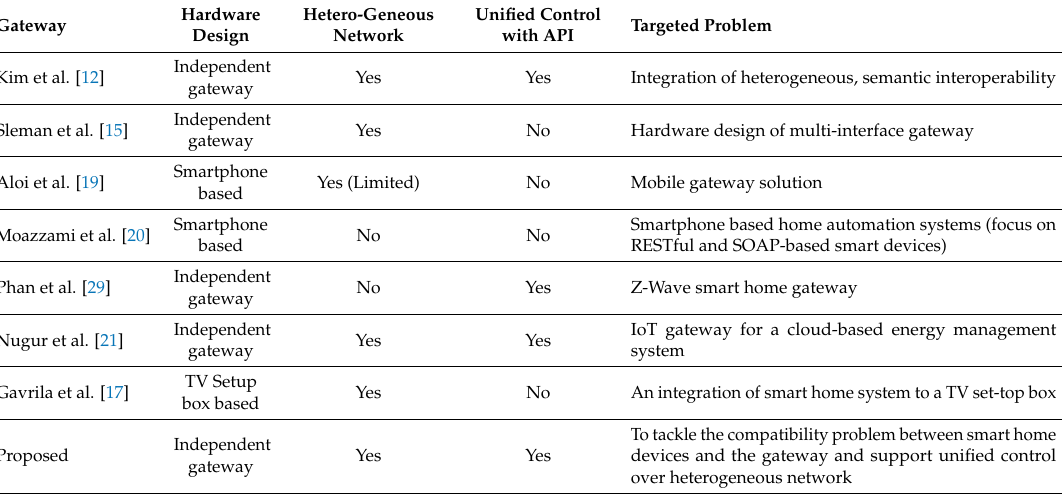
Table 2. Comparison of previous studies about smart home